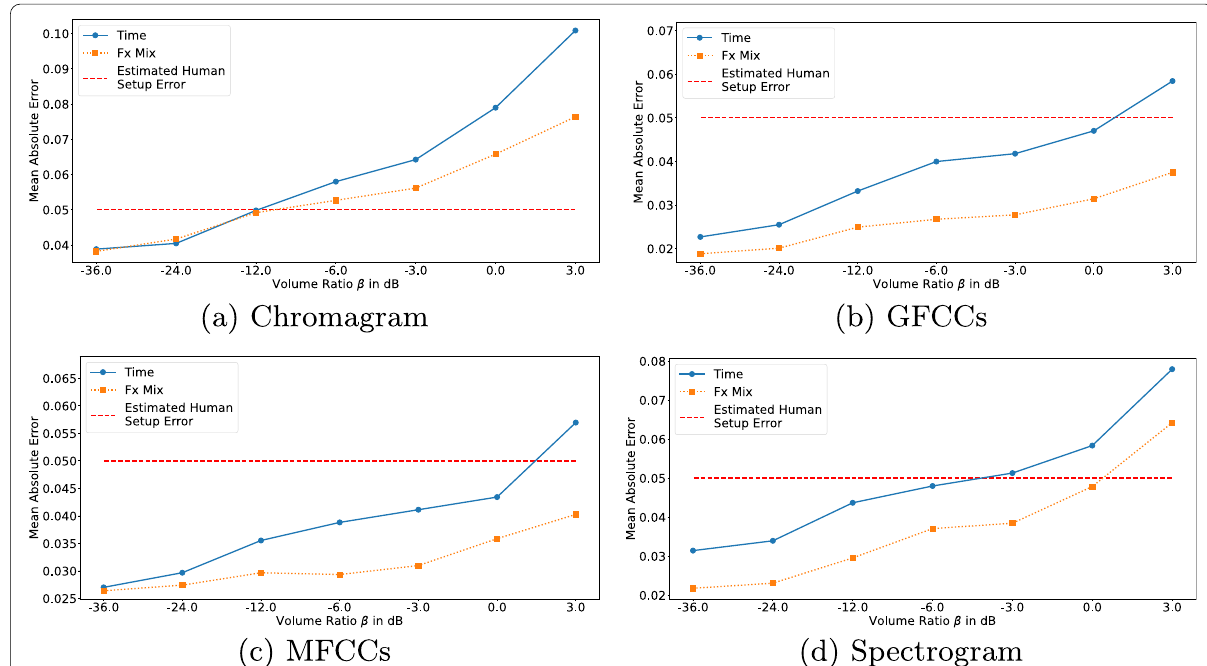
Fig. 8 Mean absolute error of the parameter extraction for the distortion effect of the a convolutional neural network (CNN) and b Jürgens et al. [12], the tremolo effect of the c CNN and d Jürgens et al. and the slapback delay effect of the e CNN and f Jürgens et al. The CNN was used with mel-frequency cepstral coefficients as time-frequency representation